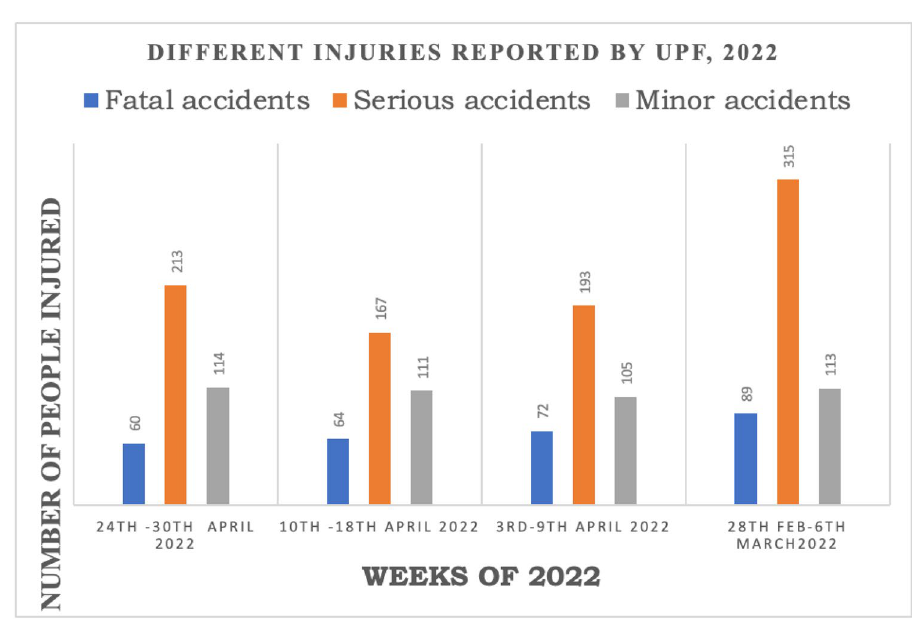
Fig. 1 The nature of injuries, as reported by police, revealing high costs of treatment incurred by the